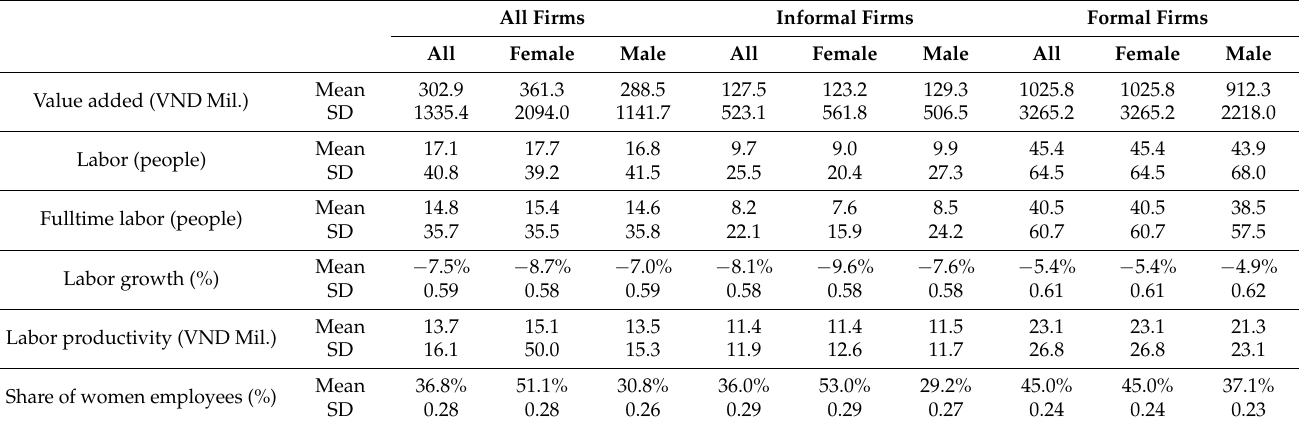
Table 6. Mean and deviation of performance indicators by gender and sector. All